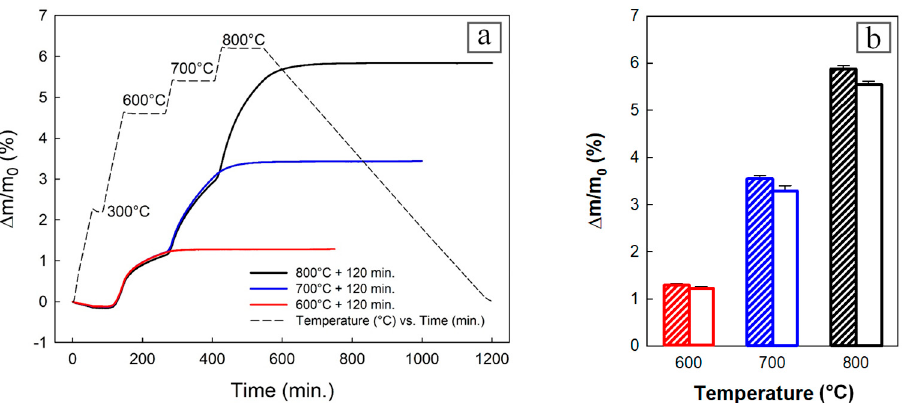
Figure 1. Weight gain of oxidized samples during heating in air. ( a ) Thermal oxidation was per- formed in the TG apparatus at the final temperature of 600 °C (red line), 700 °C (blue line), or 800 °C (black line). ( b ) Comparison of the final relative weight gain obtained for small samples subjected to TG analysis (hatched bars) and corresponding bulky CIP powder mixture oxidized in an oven (empty bars) at the final temperature of 600 °C (red), 700 °C (blue), or 800 °C (black).